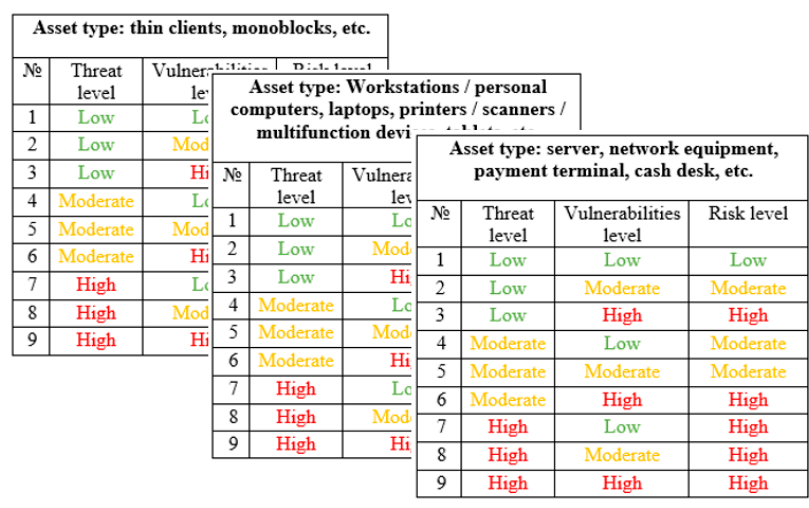
Figure 7. Risk level calculation matrices for assets of different criticality.